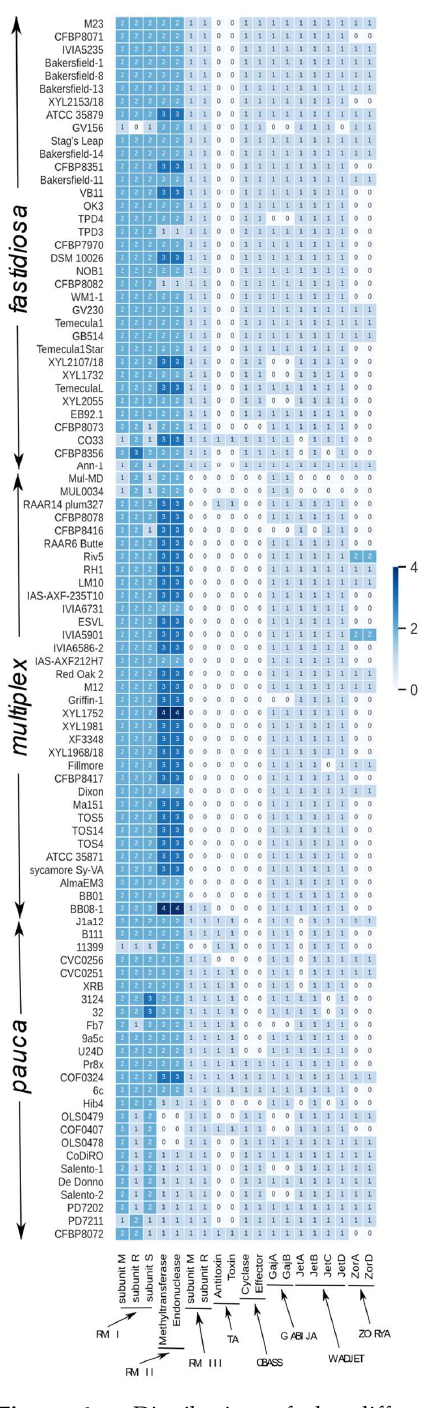
Figure 6. Distribution of the different immunity systems detected in the genomes of X. fastidiosa